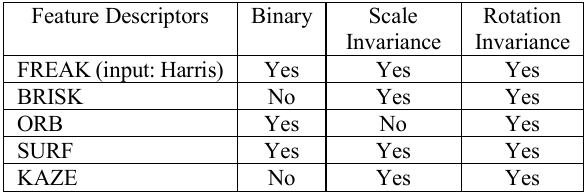
Table 2. Feature descriptors used in this study.